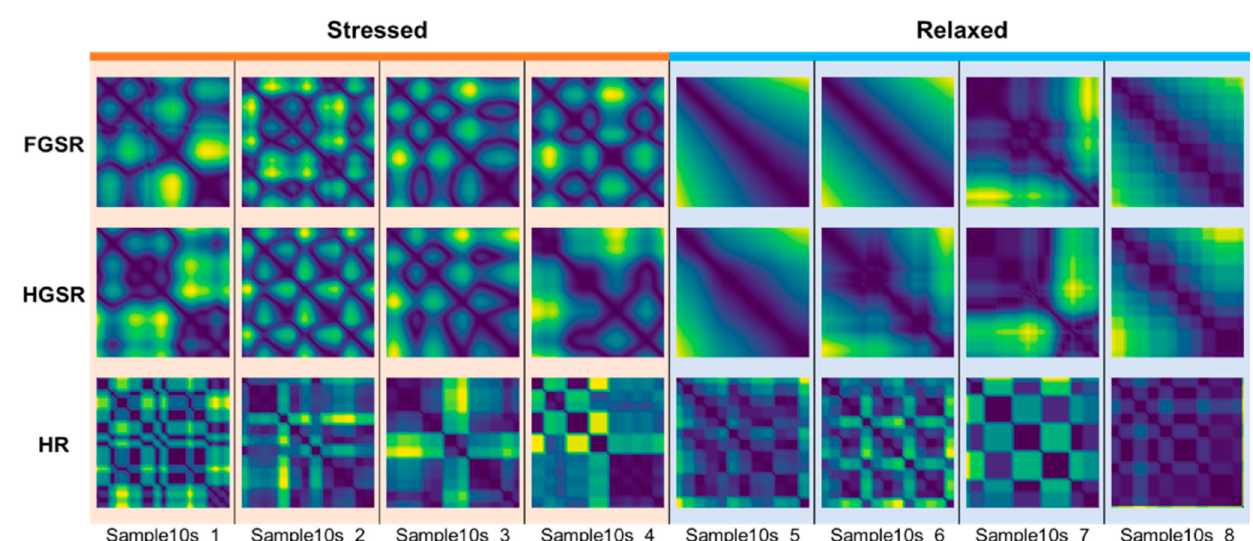
Figure 3. Examples of Cont-RPs for short-term (30 s) FGSR, HGSR, and HR signals.